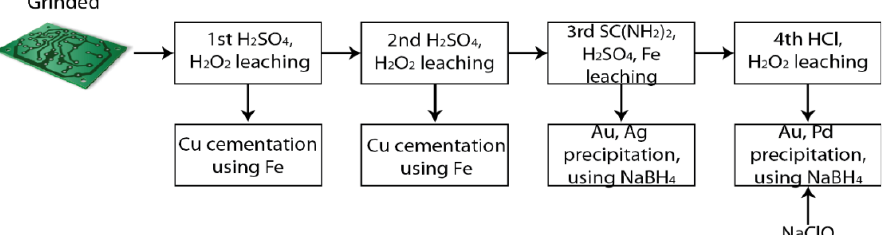
Figure 2. Recovery of PCB metals based on hydrometallurgy with sulfuric acid, hydrogen peroxide, and acidic thiourea leaching .